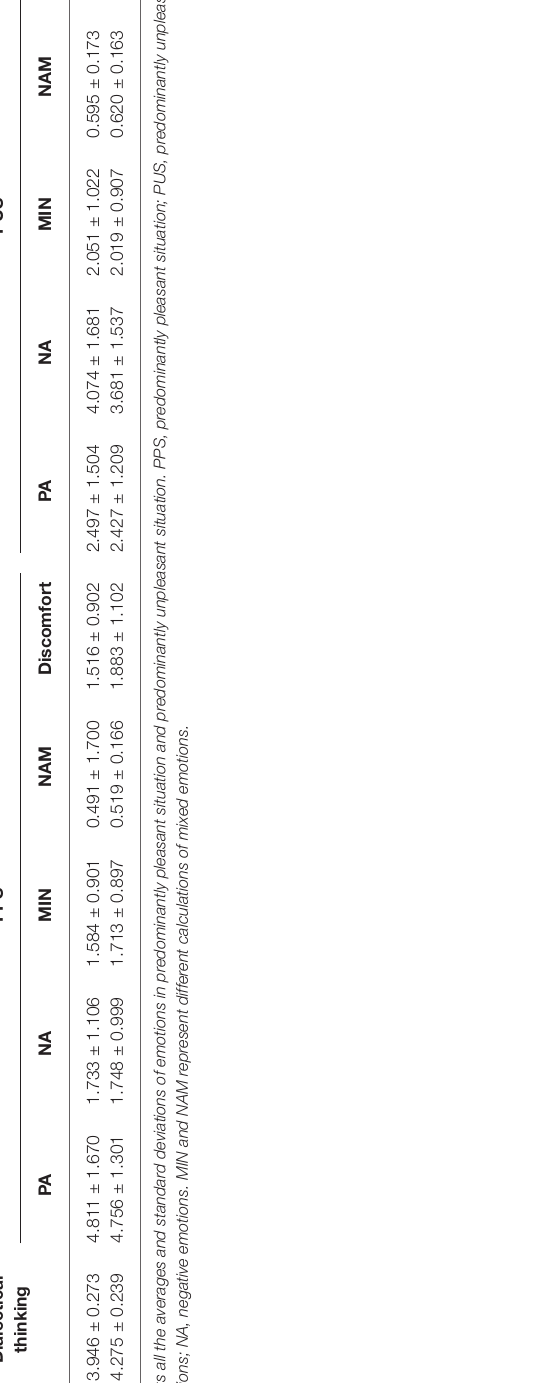
The correlation of all variables mentioned before is shown in Table 2 . We conducted mediation analyses on the two different situations separately (PPS and PUS). In the PPS, results indicated that culture significantly negatively predicted dialectical thinking, β = − 0.543, p < 0.001. When culture and dialectical thinking both entered the model, dialectical thinking significantly positively predicted MIN, β = 0.188, p < 0.05, and discomfort, β = 0.213, p < 0.01. The direct effect of culture was not significant on MIN, NAM, and discomfort, β MIN = − 0.01, β NAM = − 0.04, β DIS = − 0.09, p > 0.05. The Bootstrap confidence intervals of the indirect effect of culture on MIN were [ − 0.121, − 0.009], indicating that dialectical thinking played a significant indirect effect on the relationship between culture and MIN, β = − 0.079, p < 0.001. The Bootstrap confidence intervals of the indirect effect of culture on NAM were [ − 0.117, − 0.001], indicating that culture had a significant indirect effect on NAM, β = − 0.061, p < 0.001. The Bootstrap confidence intervals of the indirect effect of culture on discomfort were [ − 0.173, − 0.059], indicating that culture had a significant indirect effect on discomfort, β = − 0.116, p < 0.001. Figure 2 shows the standardized values of our mediation model, and the model fit indexes are shown in Table 3 . However, in the PUS when culture and dialectical thinking both entered the model, the effects of dialectical thinking on T A